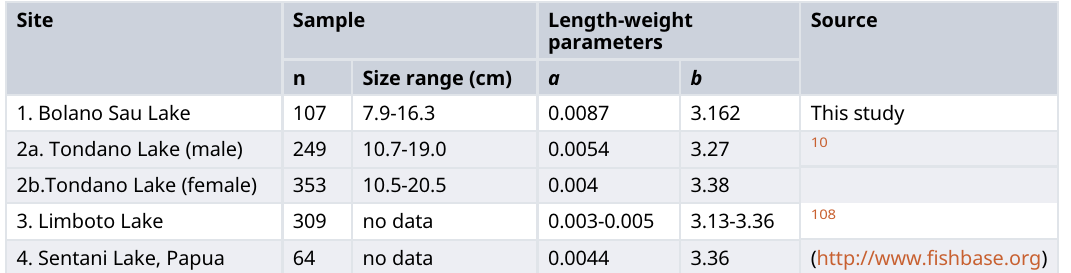
Table 7. Length-weight parameters and size range of Giuris sp. from sites in